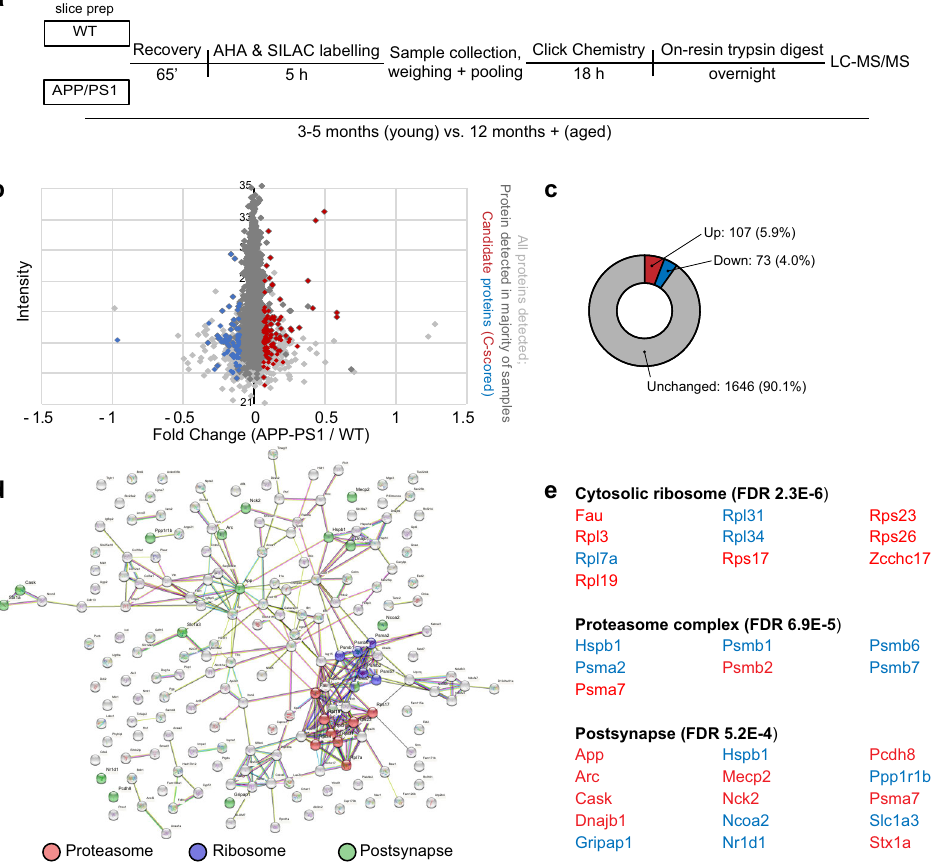
mentary Table 1, Supplementary Data 1), closely associated with the KEGG pathways ‘ Alzheimer ’ s disease ’ (Fig. 5 Cluster 5; Supplementary Fig. 5, Supplementary Data 1) and ‘ protein pro- cessing in the endoplasmic reticulum ’ (Fig. 5 Cluster 1; Supple- mentary Fig. 6, Supplementary Data 1). The GO terms ‘ synapse ’ (Fig. 5 Cluster 2; Supplementary Fig. 7, Supplementary Data 1) and ‘ synaptic vesicle cycle (Fig. 5 Cluster 3; Supplementary Fig. 8, Supplementary Data 1) were enriched in this analysis, as were the GO terms ‘ axo-dendritic transport ’ (Fig. 5 Cluster 4; Supple- mentary Fig. 9, Supplementary Data 1), ‘ myelin sheath ’ (Fig. 5 Cluster 5; Supplementary Fig. 5, Supplementary Data 1), ‘ mito- chondrial part ’ and ‘ electron transfer activity ’ (Fig. 5 Cluster 6; Supplementary Fig. 10, Supplementary Data 1). Dysregulation of ribosomal protein synthesis is a common feature in APP/PS1 mice throughout the aging process . As described above, C-score detection of candidates generated a list of proteins that were highly dysregulated in the APP/PS1 hip- pocampus (±20% compared to wild-type). When these dysregu- lated candidate proteins were compared between age groups, only 31 proteins were dysregulated in both the young and aged